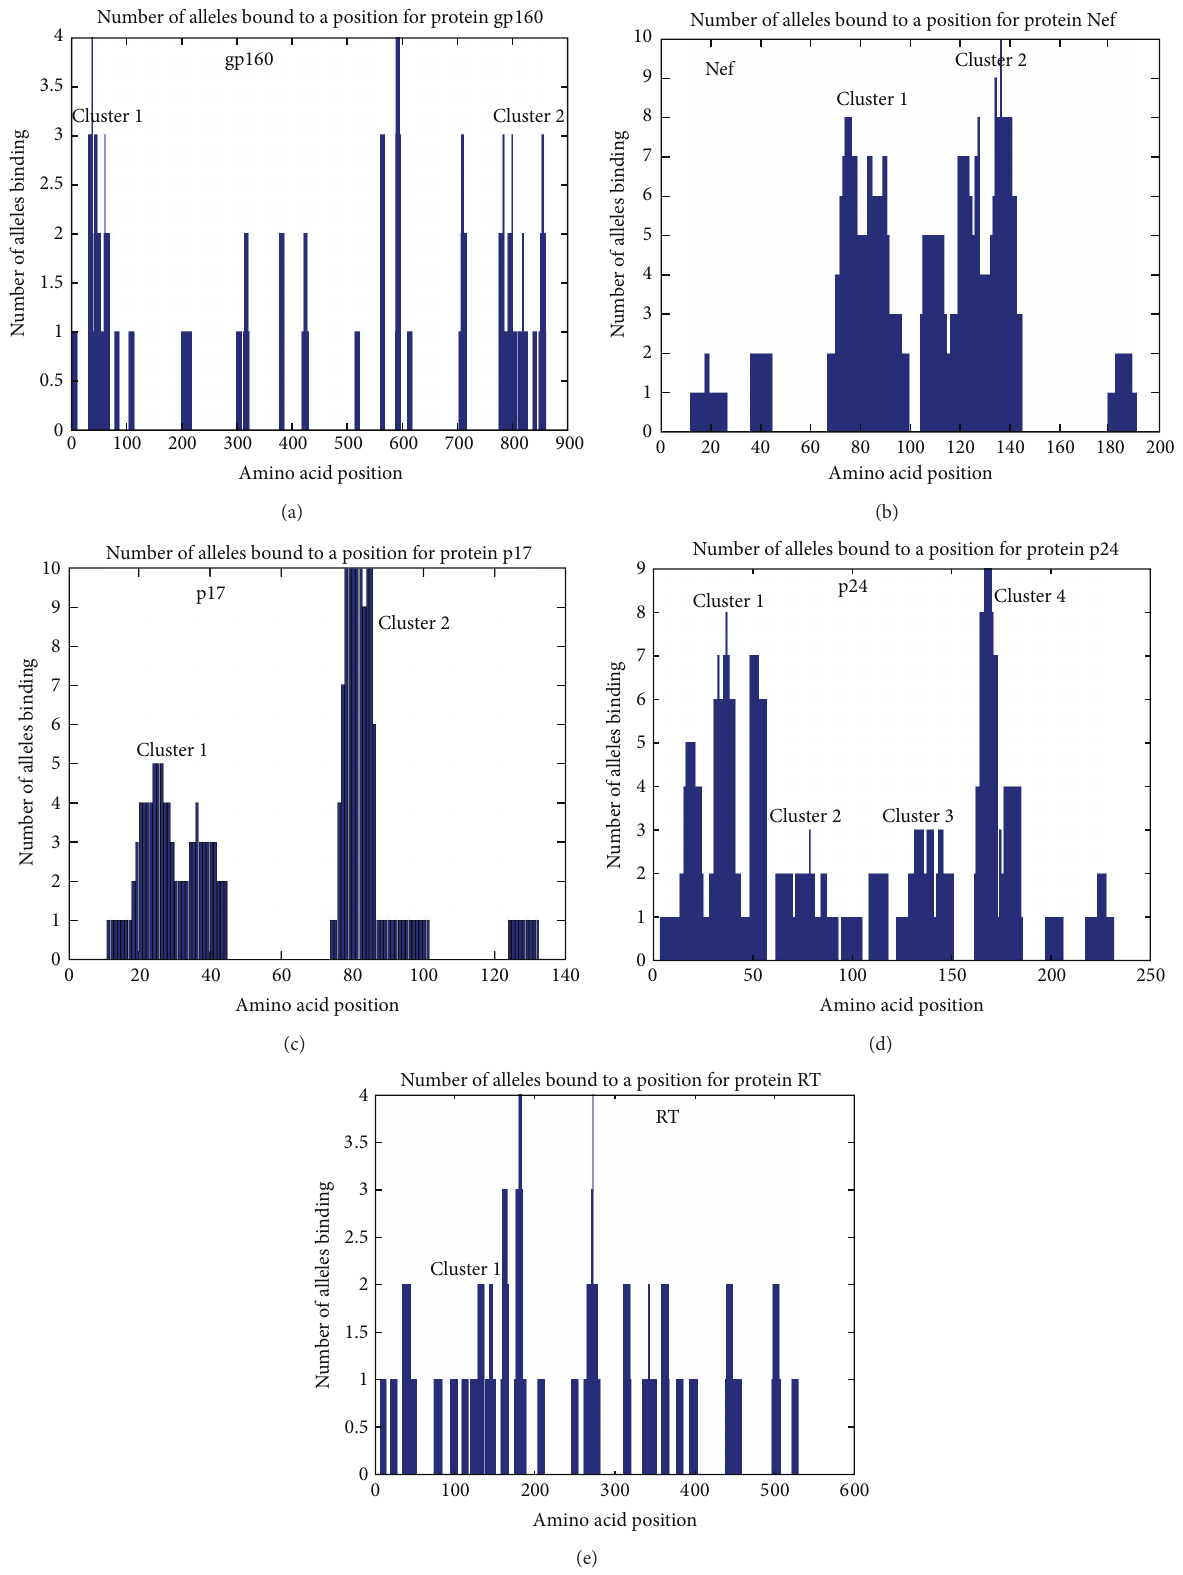
Figure 2: Clustering pattern of 5 HIV-1 proteins. The 𝑋 -axis represents the amino acid position whereas the 𝑌 -axis represents the number of allele binding to particular